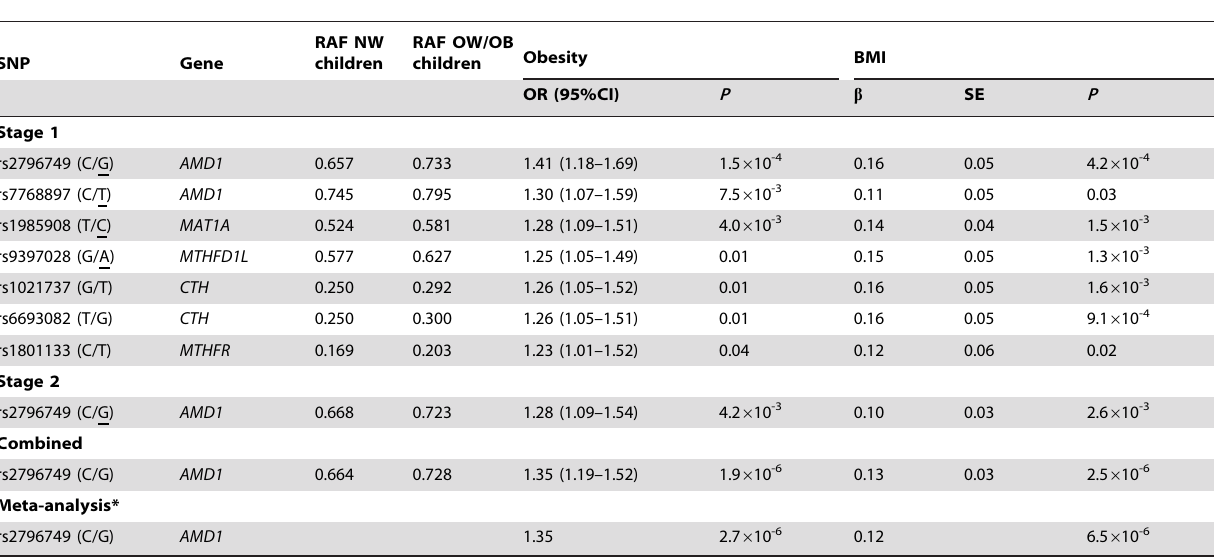
RAF: risk allele frequency; OR: odds ratio. Odds ratio are presented with respect to risk allele that are highlighted as underlined text. b : change in Z score of BMI per increase in risk allele; SE: standard error. Combined analysis was performed by combining raw genotype data from stage 1 and stage 2. Meta-analysis was performed by combining the summary estimates (OR/ b , 95%CI and S.E). No heterogeneity in two study population was observed (P value for Cochrane’s Q statistic=0.48 and Iˆ2 heterogeneity index=0.0). *OR/ b and P value for fixed effect meta-analysis.